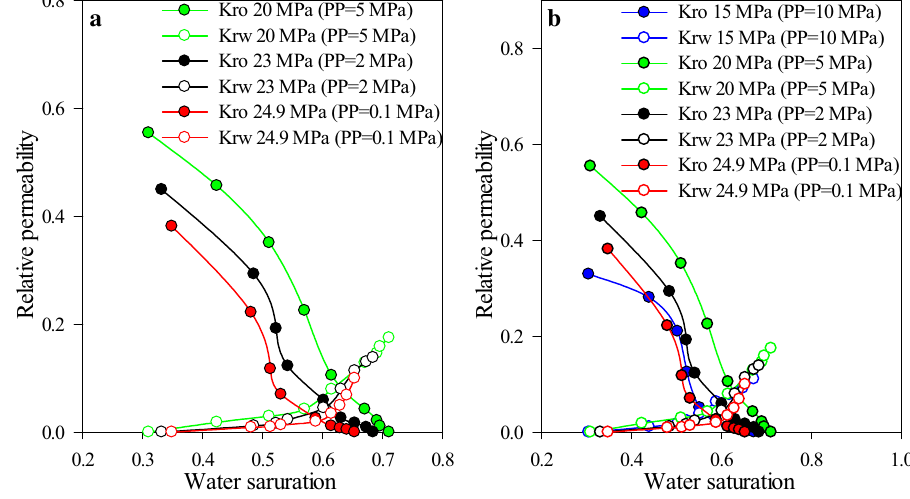
Fig. 10 Effect of pore pressure variation on nanofluid–oil rela- tive permeability: a low pore pressure range and b low-to- relatively high pore pressure